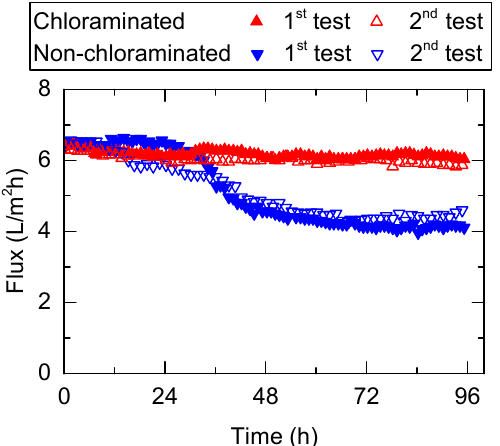
Figure 2. Changes in flux during the pre-concentration of primary wastewater effluent using a FO membrane with and without chloramination (cross flow rate = 0.5 L/min and temperature = 20 °C).